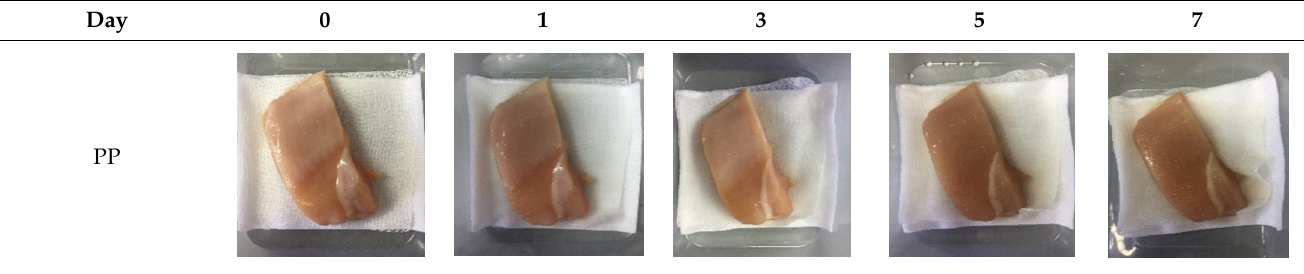
Figure 10. The L*, a*, and b* values of chicken breast fillets stored in PP container and PBS/TPS film laminated tray during storage at 4 °C for seven days. Note: Color parameters: L* (from 0 black to 100 white), a* (from -a* green to +a* red), and b* (from -b* blue to +b* yellow). PP: polypropylene microwavable container (control); PBS/TPS: PBS/TPS film (untreated); PBS/TPS + BM 1.5%: PBS/TPS film + 1.5% Biomaster silver; PBS/TPS + BM 3%: PBS/TPS film + 3% Biomaster silver; PBS/TPS + SAN 1%: PBS/TPS film + 1% SANAFOR; PBS/TPS + SAN 2%: PBS/TPS film + 2% SANAFOR. Error bars indicate standard deviation (n = 3). The different A–F capital letters are significantly different ( p < 0.05) among treatment for each day. The different a–d lowercase letters are significantly different ( p < 0.05) among storage day for each samples. Table 2. The overall visual quality of chicken breast fillets stored in PP container and PBS film laminated tray during storage at 4 °C for seven days.